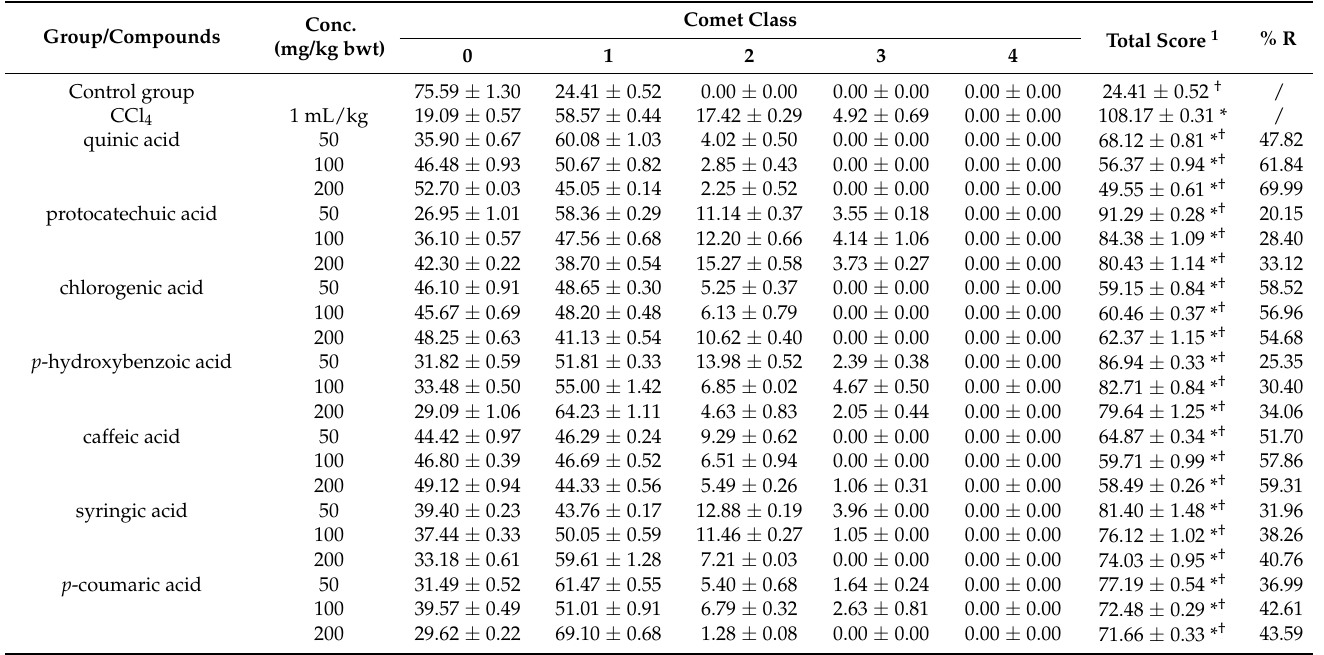
Table 8. DNA damage in livers of rats exposed to CCl 4 and different doses of compounds found in N. cataria